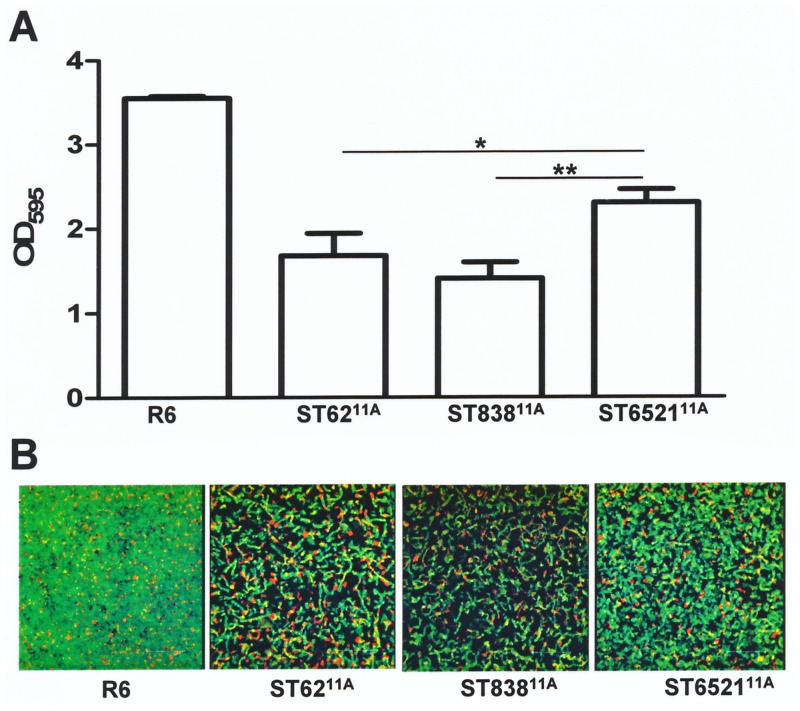
Biofilm forming capacity of serotype 11A pneumococcal isolates.(A) Biofilm formation of S. pneumoniae R6 strain and isolates of genotypes ST6211A, ST83811A and ST652111A. (B) Confocal microscopy showing images of the biofilms formed after staining with the BacLight kit showing living (green fluorescence) and dead (red fluorescence) bacteria.